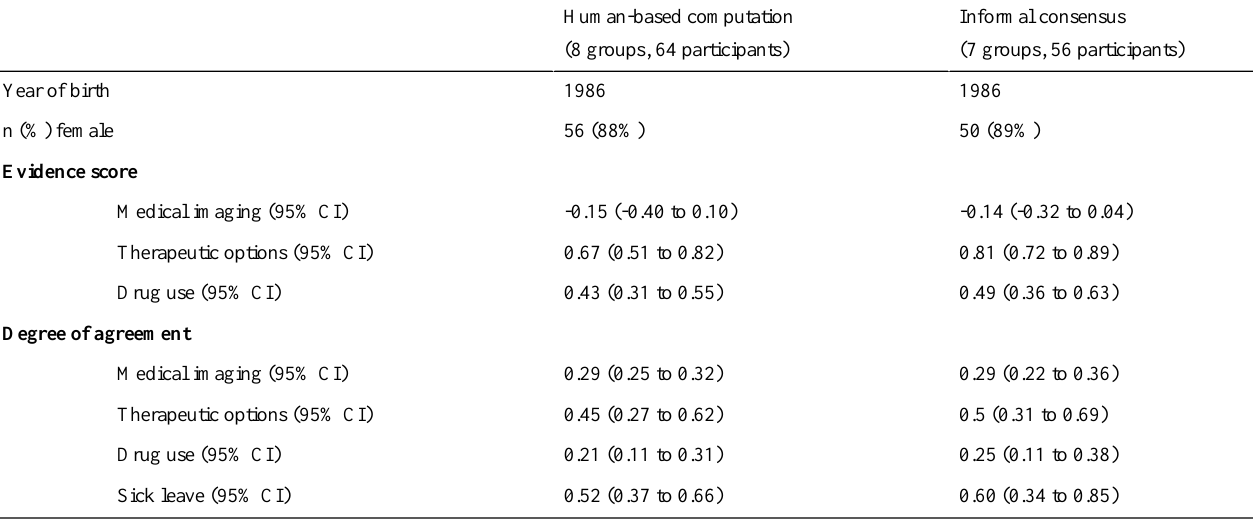
Table 1. Baseline demographic data and outcome scores.